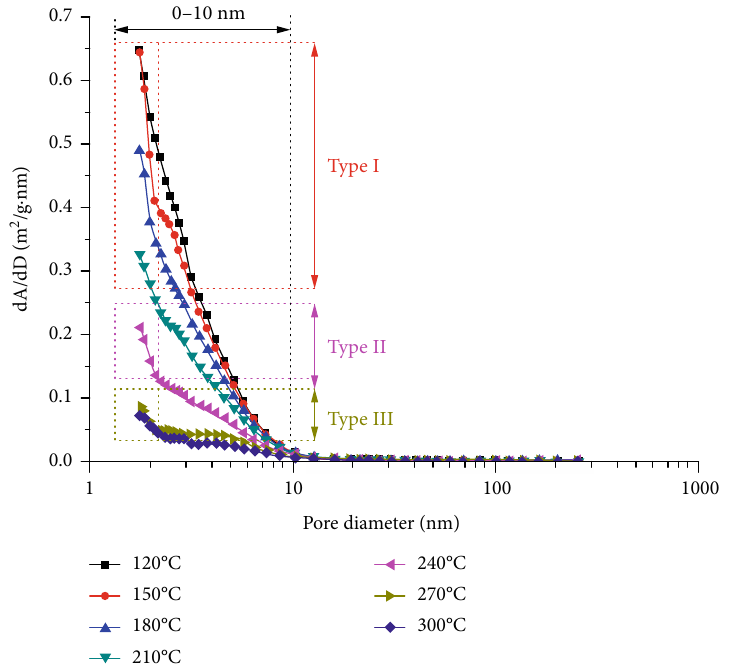
Figure 10: The incremental pore speci fi c surface area of coal under various pretreatment